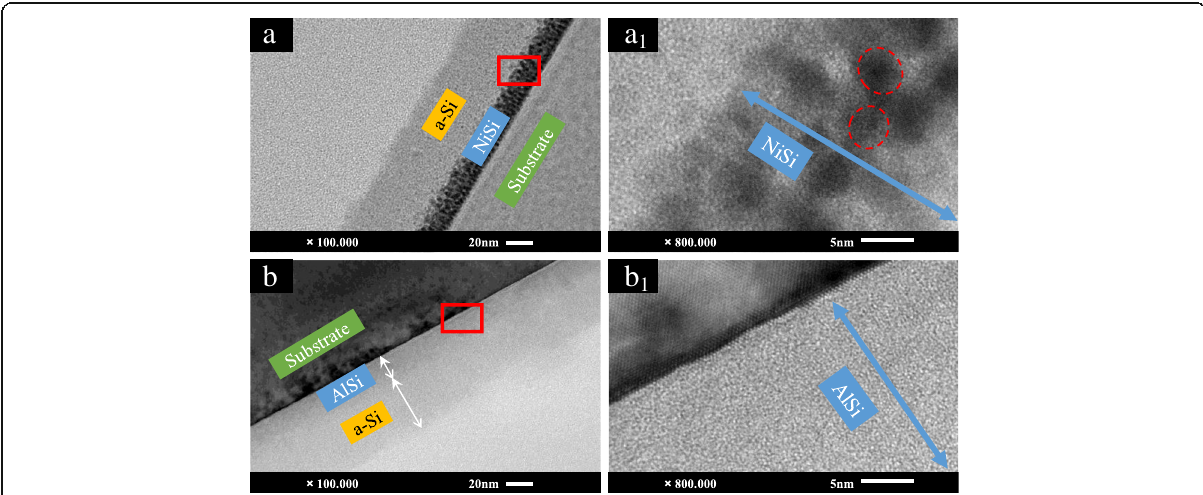
Fig. 2 The cross-sectional TEM images of a NiSi/Si (NS-1) and b AlSi/Si (AS-1) films and high-resolution images of a 1 NiSi/Si (NS-1) and b 1 AlSi/Si (AS-1) films derived from the areas marked with red rectangles in Fig. 2a, b